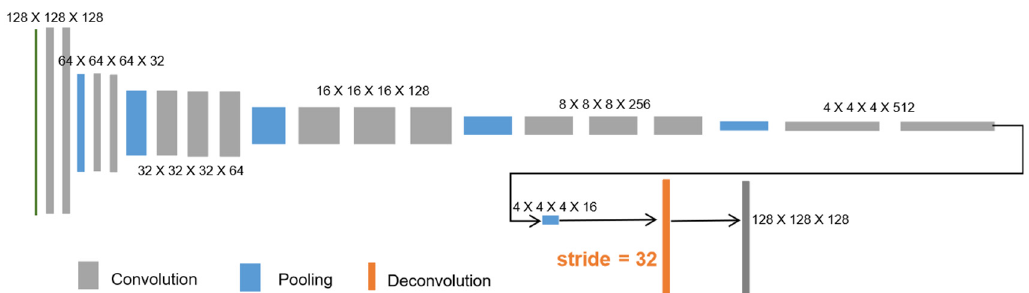
Figure 8. When the stride is 32, we get the predicted result of 128 × 128 × 128.